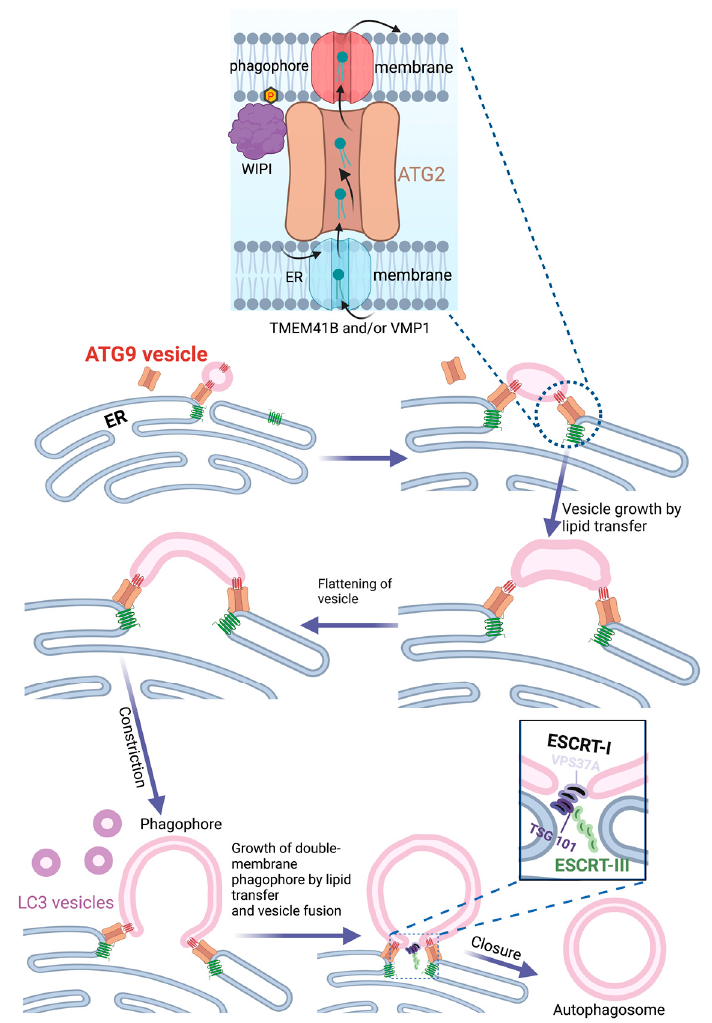
Figure 2. Lipid transfer from ER during phagophore biogenesis. The lipid channel ATG2 interacts with the lipid scramblases TMEM41B and VMP1 in the ER and ATG9 on the phagophore seed vesicle. Newly synthesized phospholipids in the ER are transferred from the luminal to the cytosolic side, where they are channeled by ATG2 to the seed vesicle. Transbilayer lipid transfer by ATG9 ensures phagophore growth. The model illustrates how the seed vesicle transforms into a double-membrane phagophore by flattening, growth, and bending. A variant of ESCRT-I that contains VPS37A is recruited to the remaining hole in the phagophore via the N-terminus of VPS37A. This causes the recruitment and activation of ESCRT-III, presumably via interactions between TSG101 in ESCRT-I and the ESCRT-III subunit CHMP4B. ESCRT-III forms filaments that close the phagophore to form an autophagosome. Prepared with BioRender (www.biorender.com) and accessed on 15 February